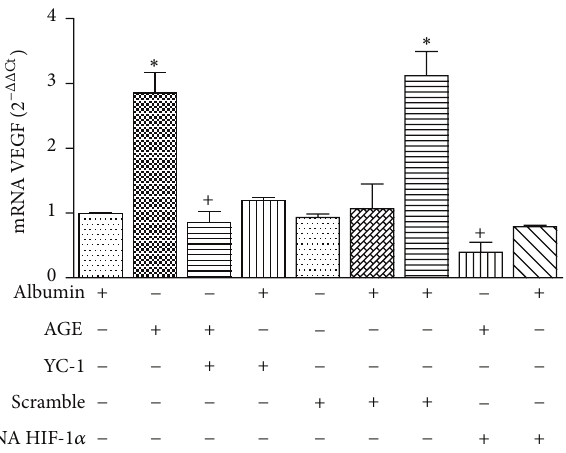
Figure 8: AGE increases VEGF mRNA expression in a HIF-1 𝛼 - dependent manner. Cells were preincubated with HIF-1 𝛼 inhibitor YC-1 or transfected with HIF-1 𝛼 siRNA or control siRNA (scramble) as indicated in Section 2. Then they were incubated with albumin or AGE, and VEGF mRNA expression was quantified by Q-RT-PCR. Bars are the mean ± SD of 3 different experiments. ∗ 𝑃 < 0.01 versus albumin; + 𝑃 < 0.01 versus